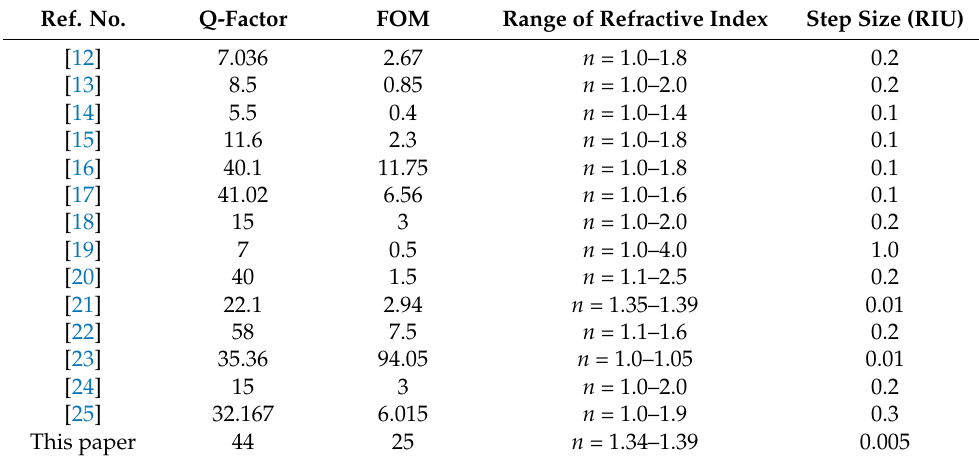
Table 1. Comparison of the sensing performance between the proposed absorber and the existing absorbers operating at terahertz frequency